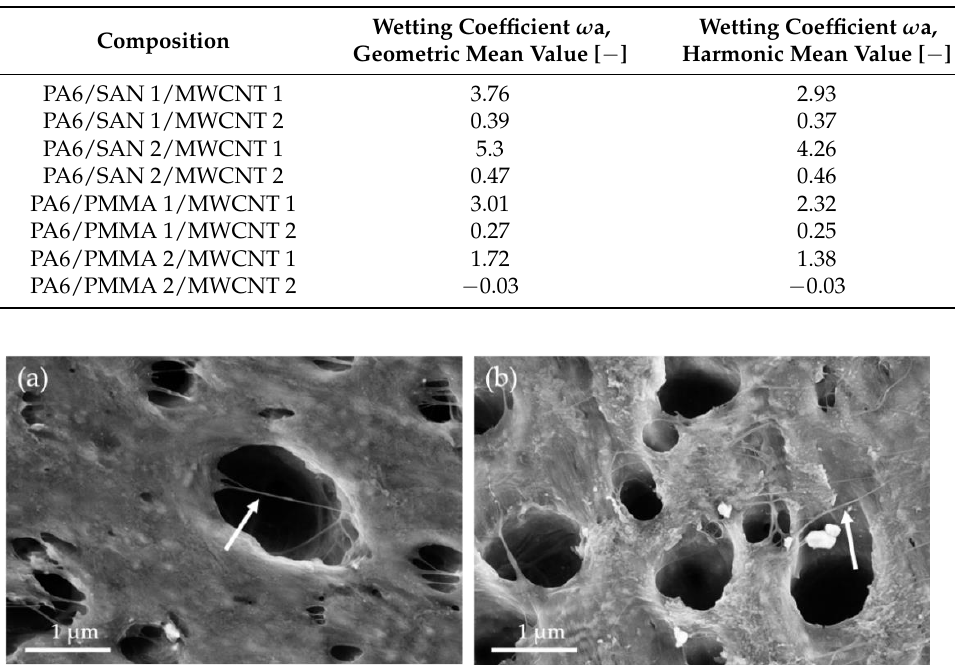
Figure 9. SEM images of flat surfaces of ( a ) PA6/SAN 90/10 + 3 wt.%SWCNT and ( b ) PA6/PMMA 80/20 + 3 wt.% SWCNT, the arrows indicate CNTs (blends were etched to remove SAN or PMMA).